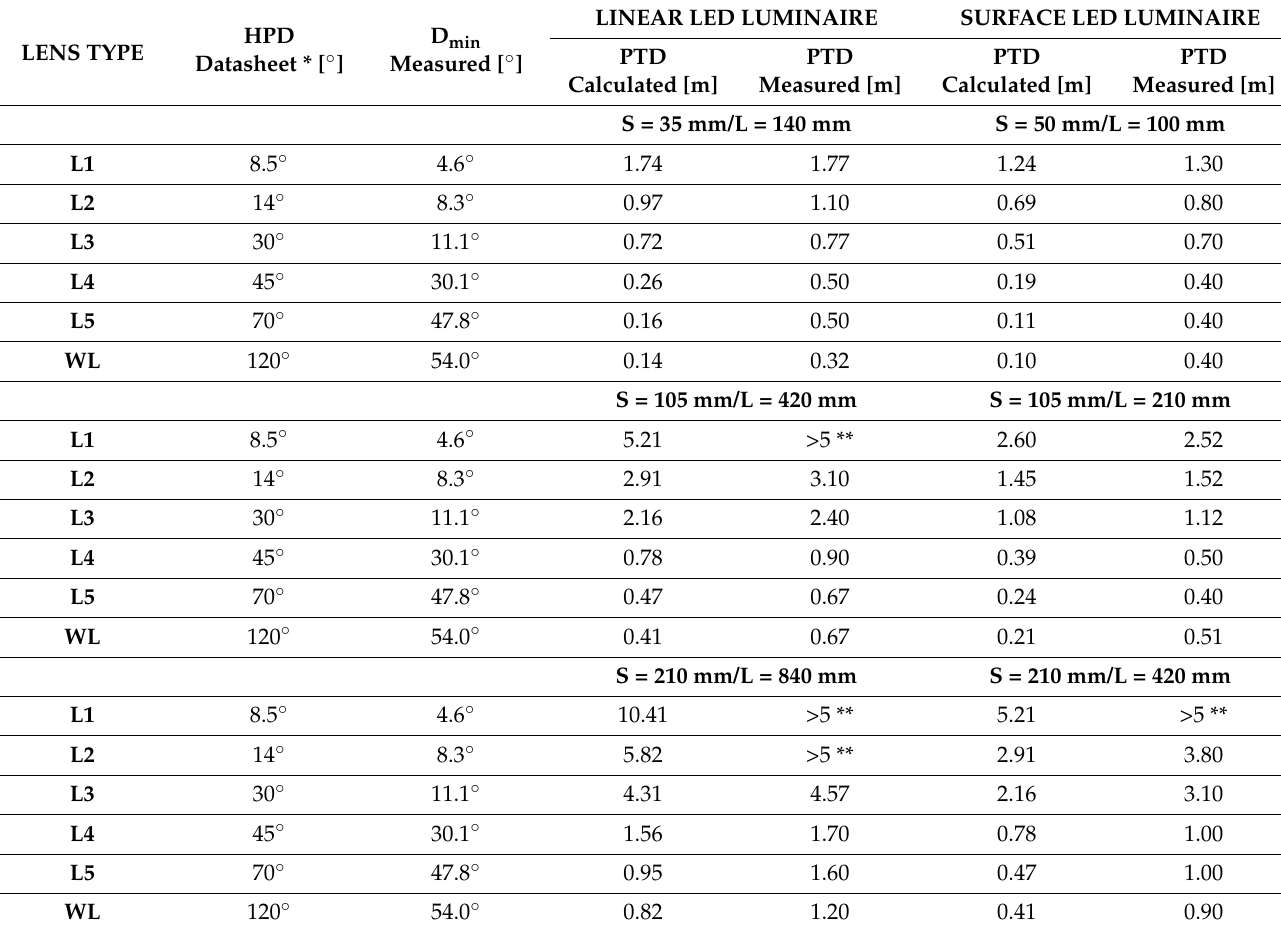
Table 1. The results of the calculations and measurements of the photometric test distance (PTD) for the test luminaires.